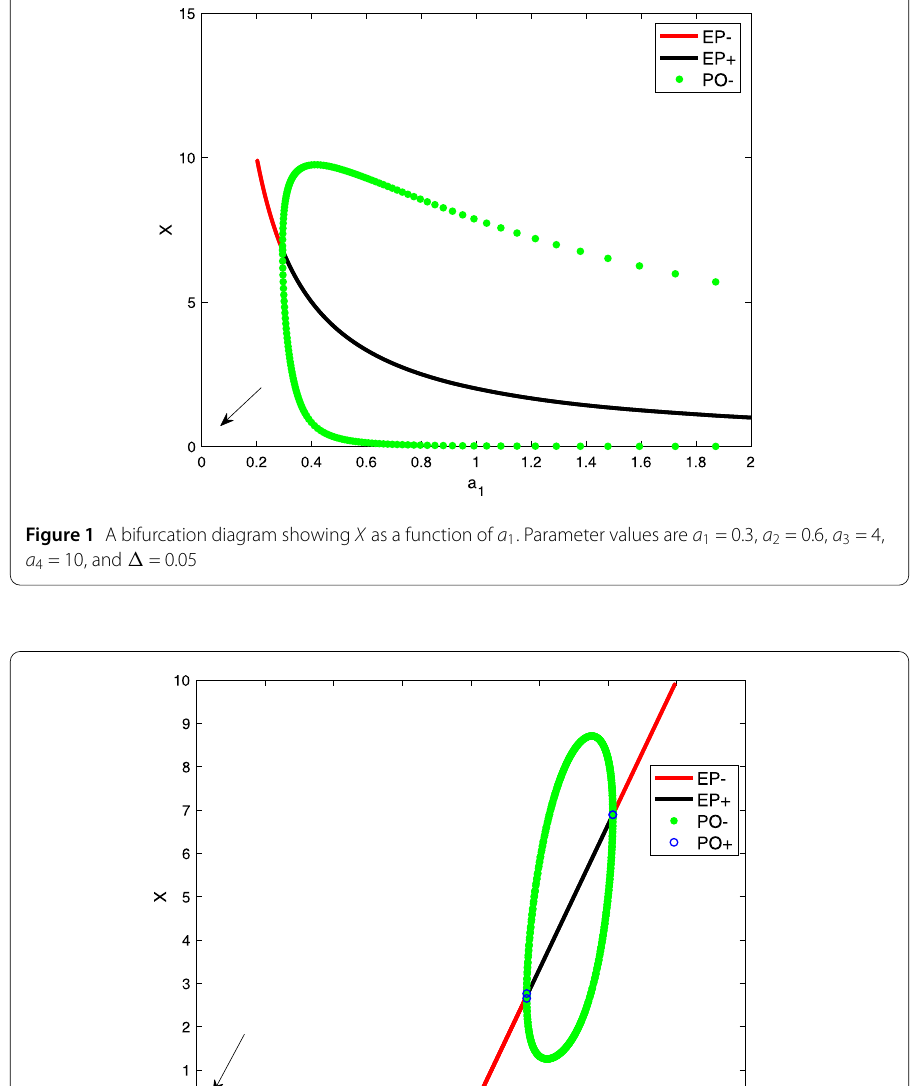
Similar effects of a 2 on the steady states of X are discussed in Fig. 2. The red, black curves represent the stable and unstable steady state branches, whereas the green circle denotes the stable limit cycles. For low and high values of a 2 , the system (2.2) has a